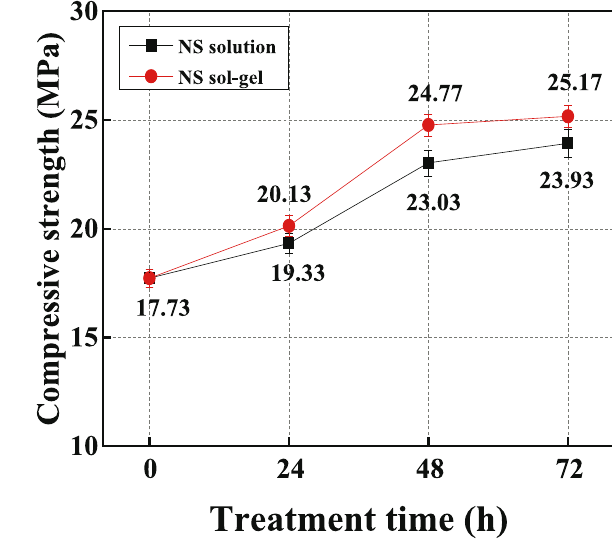
Figure 8: E ff ect of treatment time on the water absorption rate of RCA.